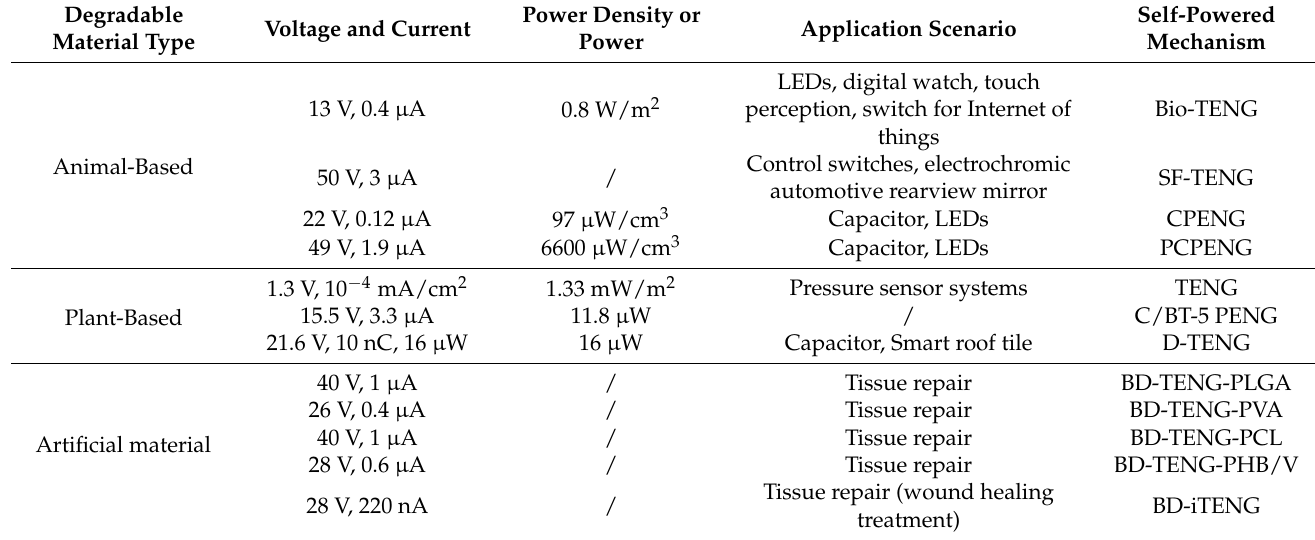
Comparisons of piezoelectric and triboelectric self-powered sensors made from different degradable materials